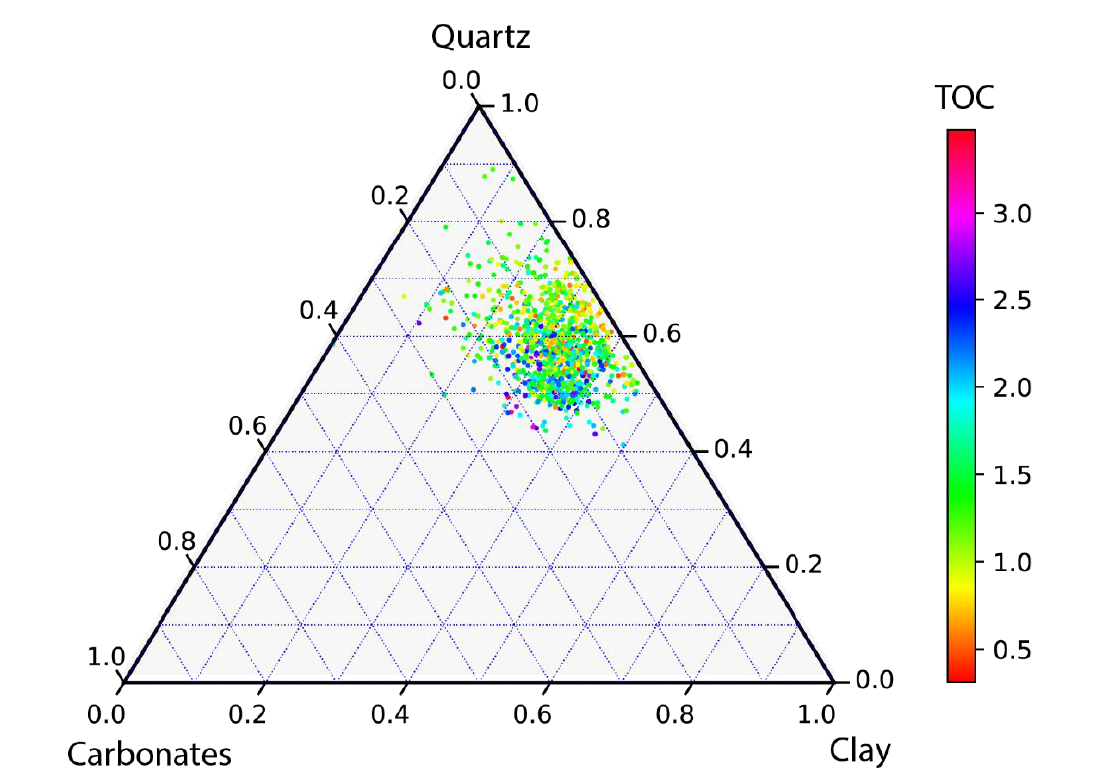
Figure 3. A ternary plot showing percentages of three major components (i.e., quartz, carbonates, and clay) of Gulong shale from the Qingshankou Formation. Data are adapted from [10 – 12].